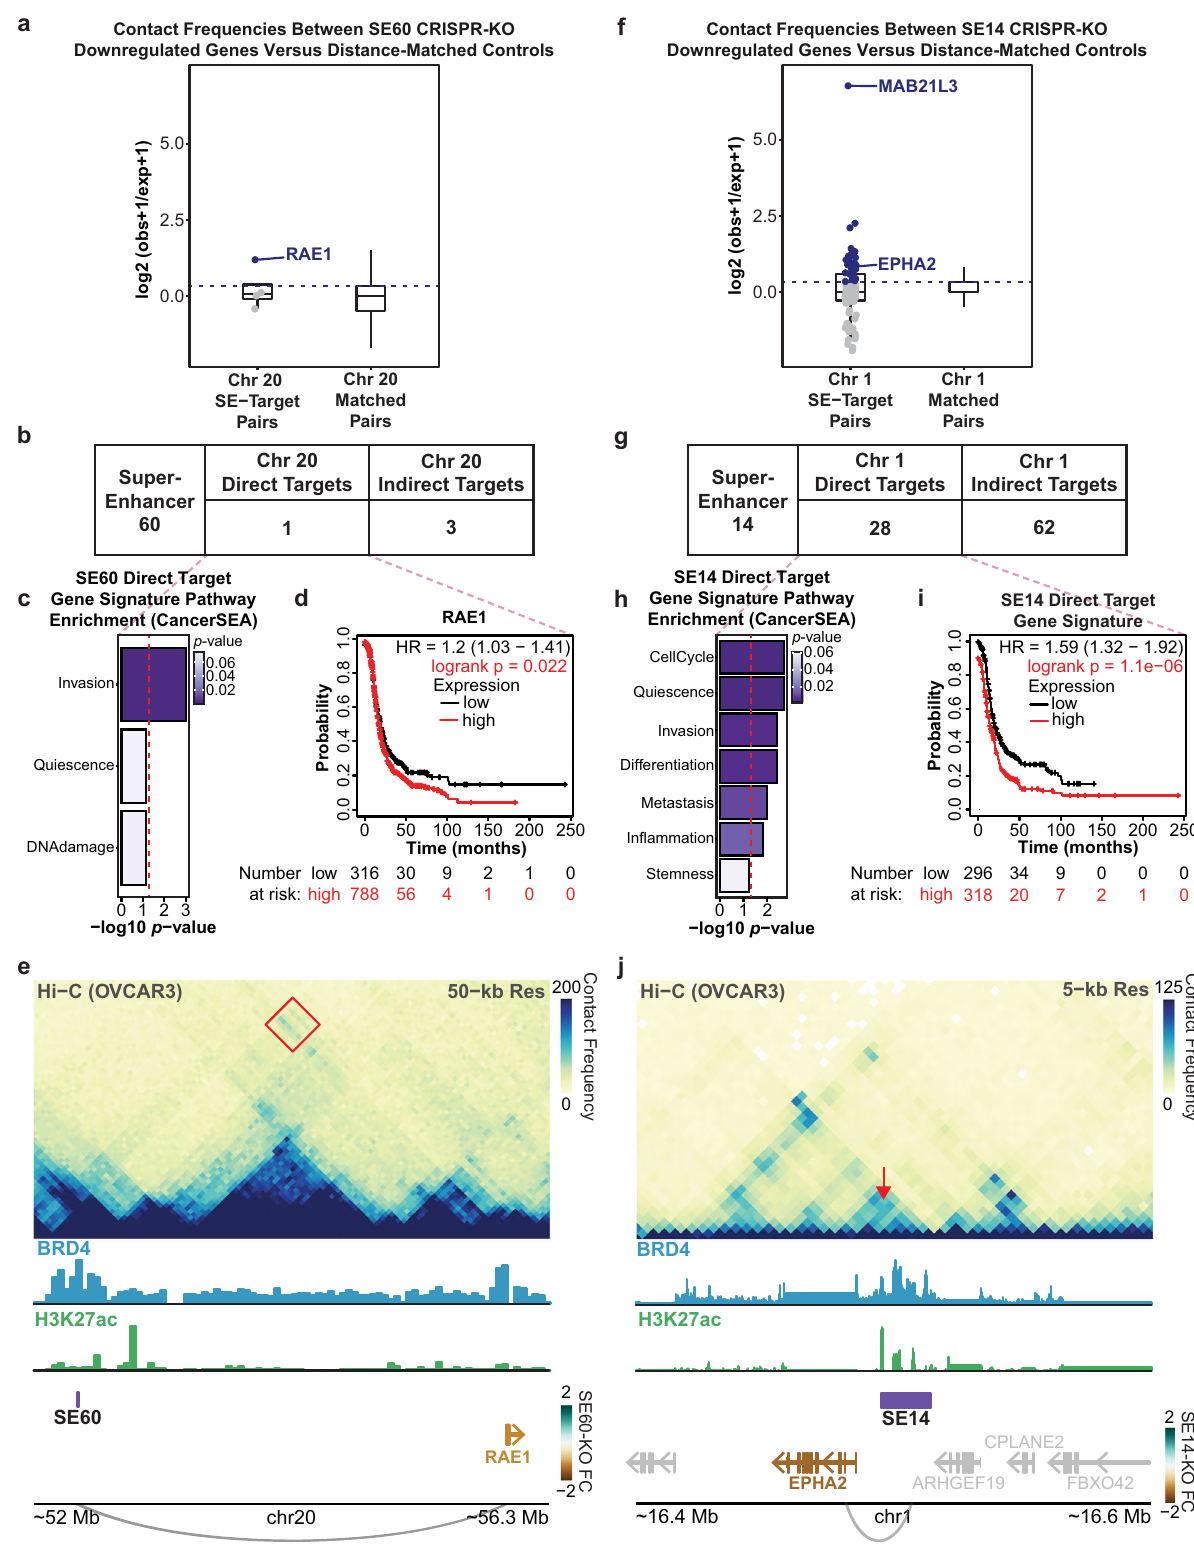
SE60 Direct Target Gene Signature Pathway Enrichment